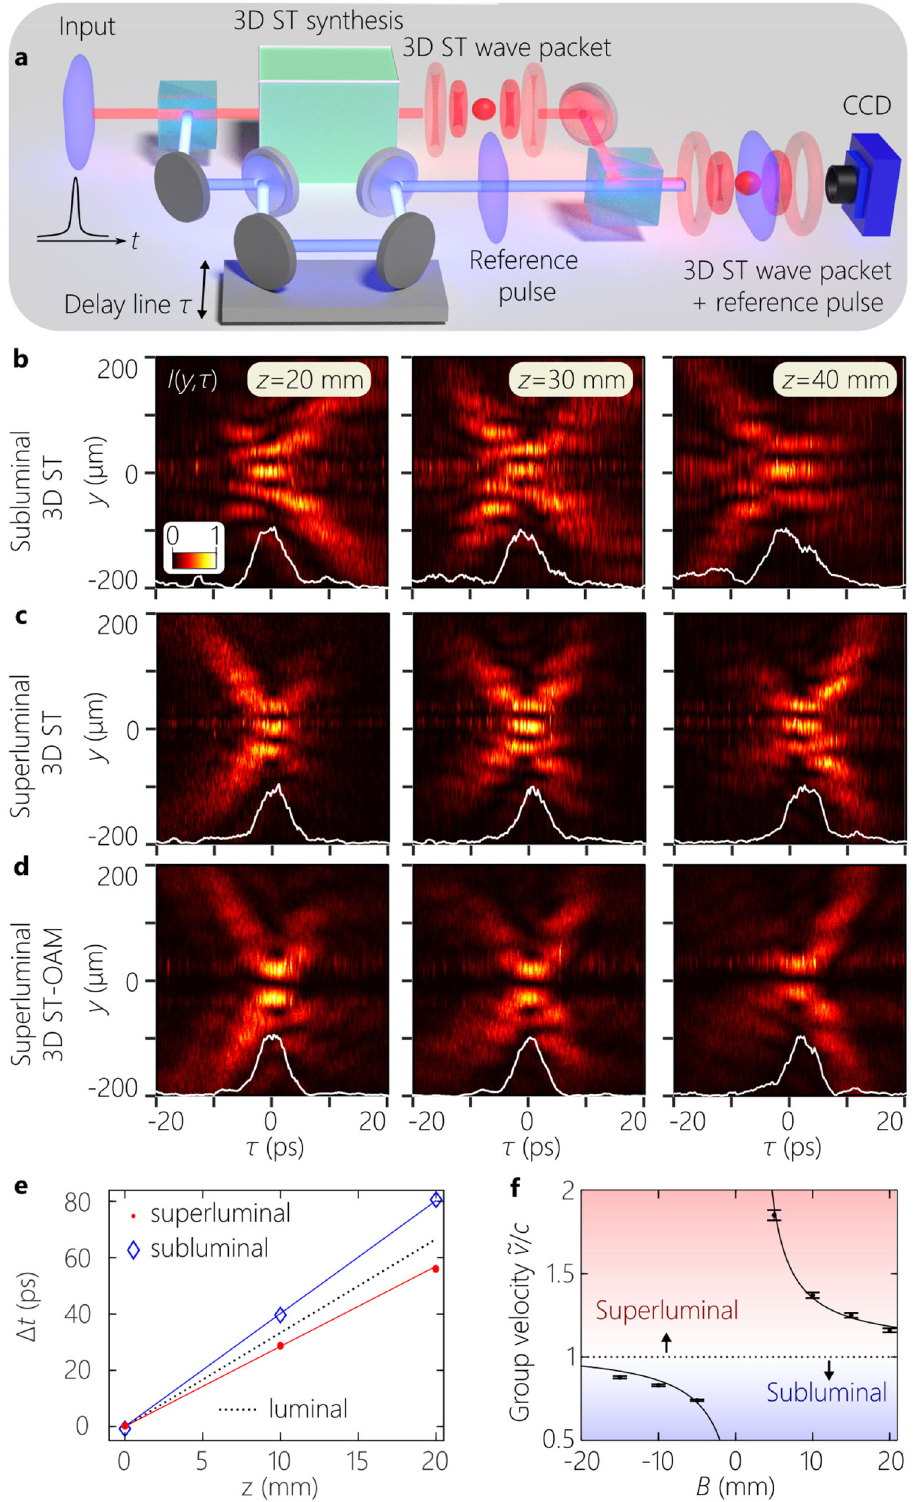
Fig.6|Reconstructingthespatio-temporalintensitypro fi leandestimatingthe group velocity for 3D ST wave packets. a Schematic of the interferometric con- fi guration for reconstructing I ( x , y , z ; t ) and estimating e v . b Measured I (0, y , z ; τ ) at z =20, 30, and 40 mm for a subluminal ( e v = 0 : 83 c ) wave packet; c for a super- luminal ( e v = 1 : 37 c ) wave packet; and d for a superluminal ( e v = 1 : 16 c ) wave packet endowed with the OAM mode ℓ =1. We also plot the section y =0 through the intensity pro fi le (white curve at the bottom of each panel), except in d where we